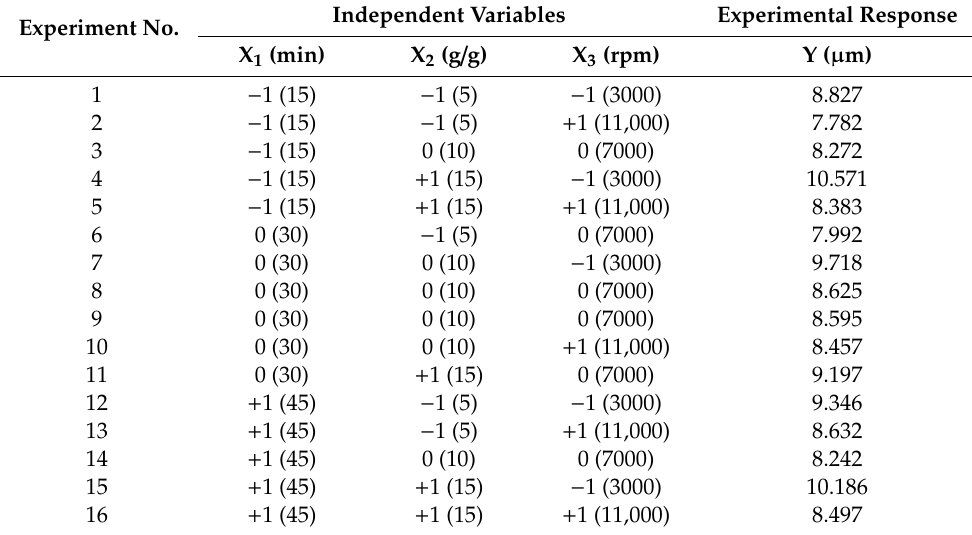
Table 2. Experimental parameters and responses for RSM optimization.